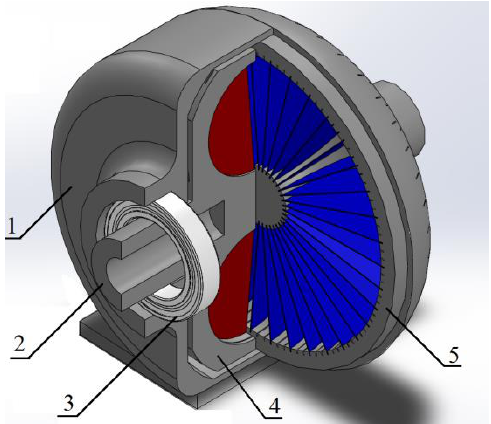
Figure 1. HB construction scheme: 1 — casing, 2 — input shaft, 3 — bearing with sealing, 4 — pump rotor, 5 — turbine rotor connected to casing.